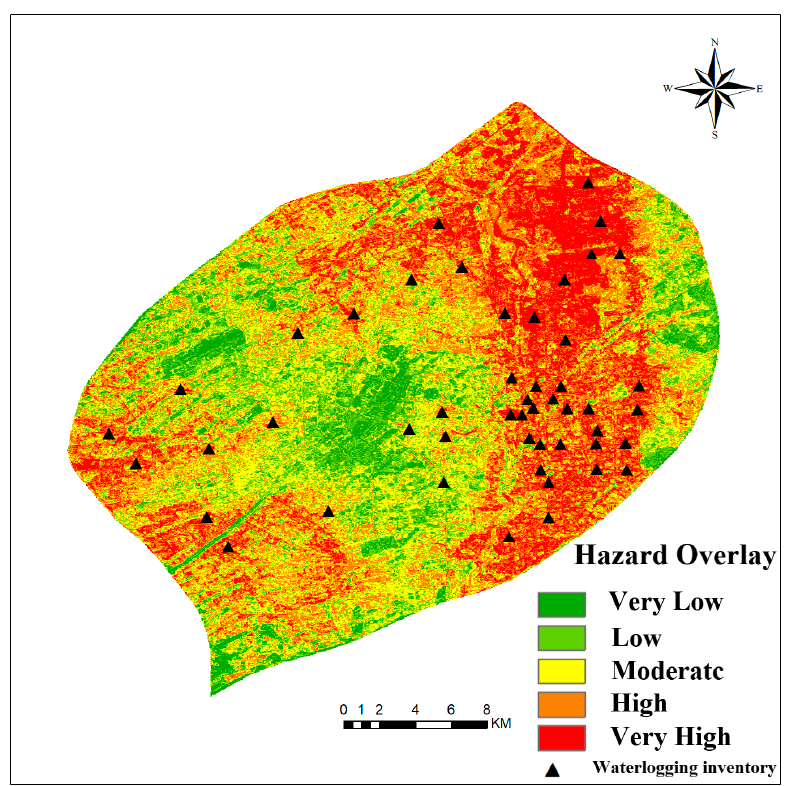
Figure 9. Waterlogging point verification map.